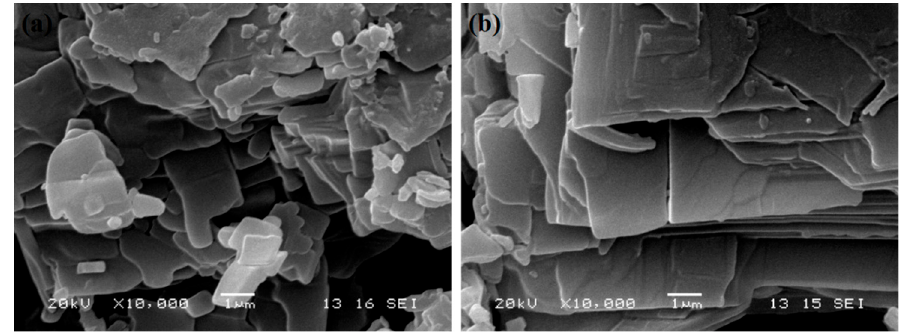
Figure 4. SEM images of the perovskites ( a ) (C 6 H 5 CH 2 NH 3 ) 2 PbBr 4 ; ( b ) (C 6 H 5 CH 2 NH 3 ) 2 PbI 4 .